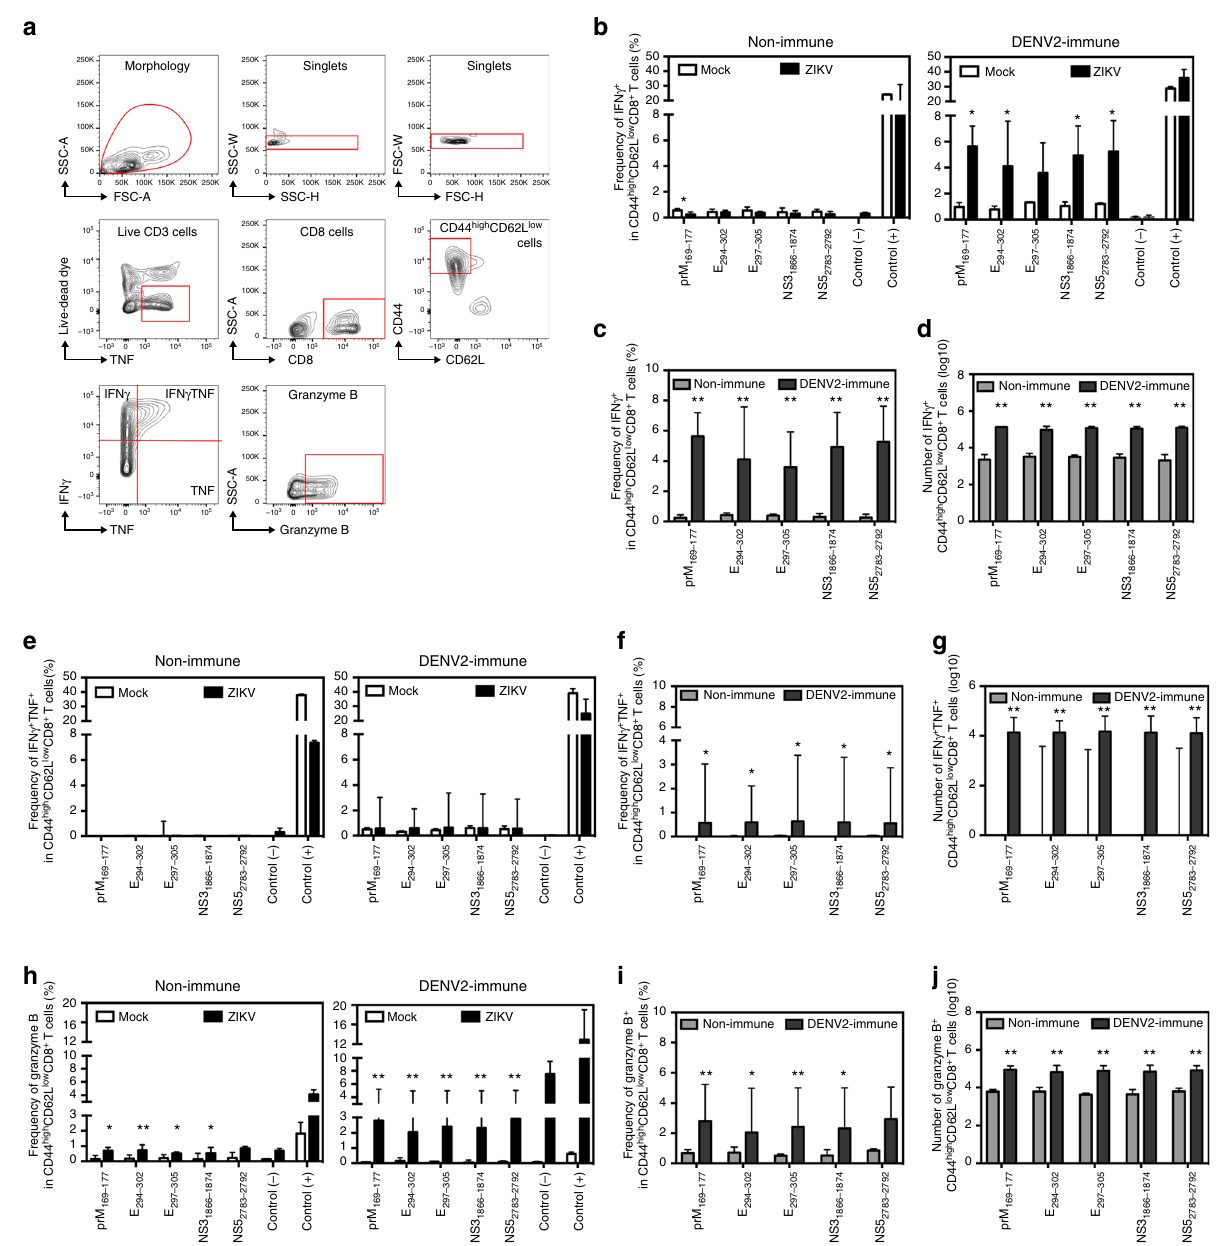
Fig. 5 Cross-reactive epitope-speci fi c CD8 + T cell response in spleens from Ifnar1-blocking Ab-treated WT dams on day 3 after ZIKV infection. Non- immune or DENV2-immune WT dams with transient Ifnar1 blockade were challenged with ZIKV at E7.5 or injected 10% FBS – PBS (MOCK) as described in Fig. 2. Three days after ZIKV infection (E10.5), mice were killed, and spleens were processed for ICS analysis. a The gating strategy is represented. b – d The percentages ( b , c ) and numbers ( d ) of CD44 high CD62L low CD8 + T cells producing IFN γ are shown. e – g The percentages ( e , f ) and numbers ( g ) of CD44 high CD62L low CD8 + T cells producing both IFN γ and TNF are shown. h – j The percentages ( h , i ) and numbers ( j ) of CD44 high CD62L low CD8 + T cells expressing granzyme B are shown. The following numbers of dams were used: Non-immune ( n = 6 MOCK and n = 6 ZIKV) and DENV2-immune ( n = 6 MOCK and n = 4 ZIKV). Data represent a pool of three independent experiments, and are expressed as median with interquartile range. * p < 0.05, ** p < 0.01. Two-tailed Mann – Whitney test was used to compare MOCK versus ZIKV-infected or non-immune versus DENV2-immune mice for each stimulation condition in b –